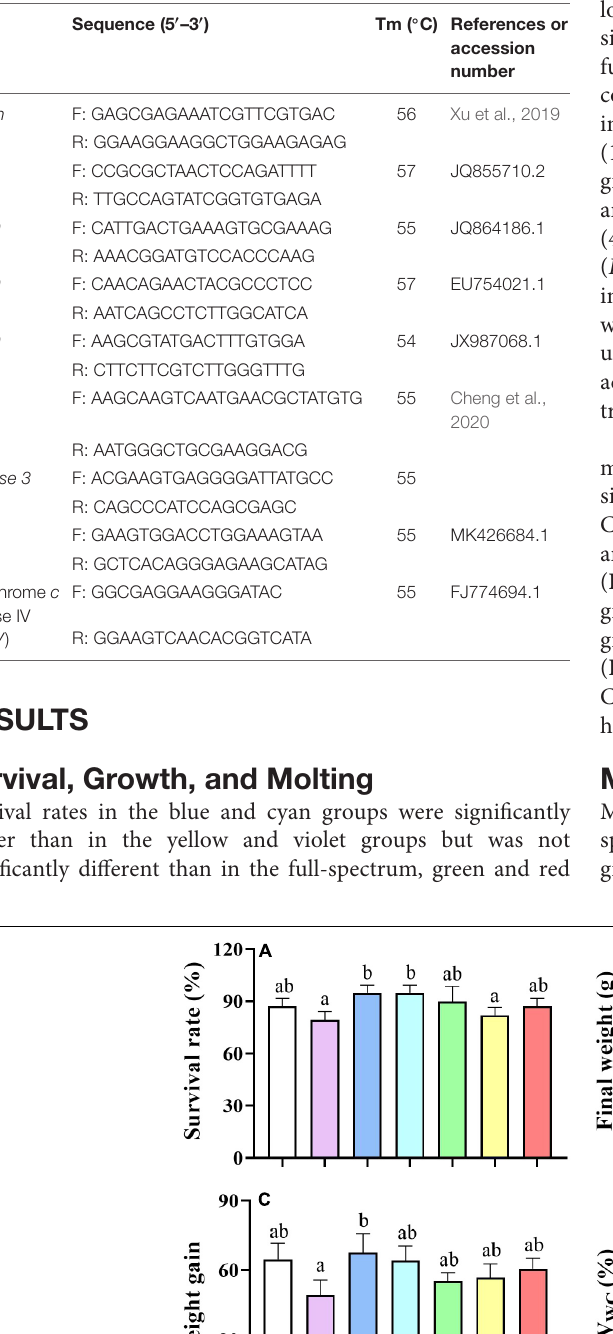
TABLE 1 | Primers used for qPCR in this study.